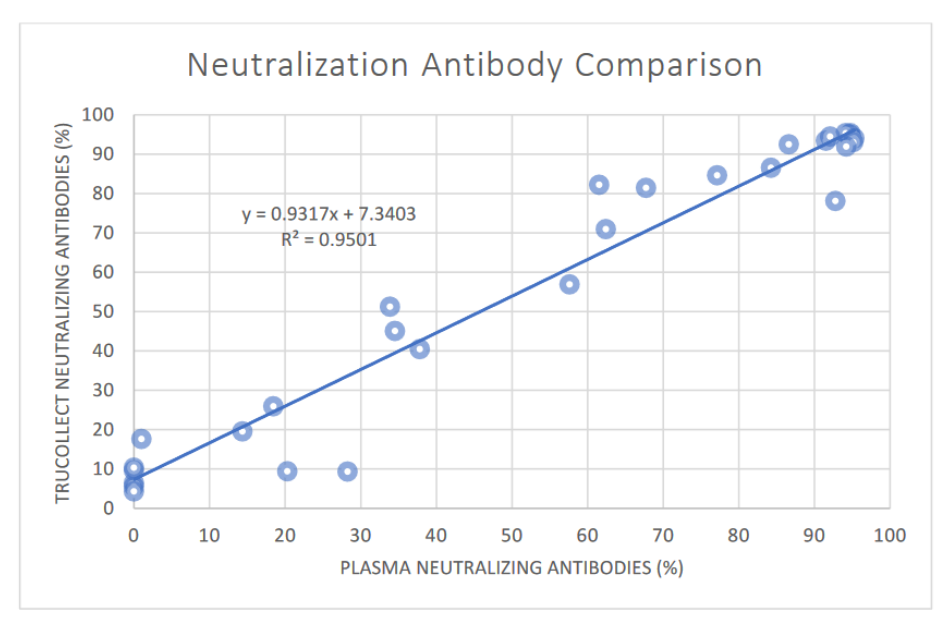
Figure 7. Correlation of SARS-CoV-2 neutralizing antibodies in paired plasma and truCOLLECT samples. A comparison of percent neutralization from 31 donors using the SARS-CoV-2 Neutralizing Antibody ELISA Kit (ThermoFisher). Capillary fingerstick blood collected with truCOLLECT (Y-axis), and Venipuncture derived plasma (X-axis) are compared; r 0.97; 95% CI [0.95, 0.99].